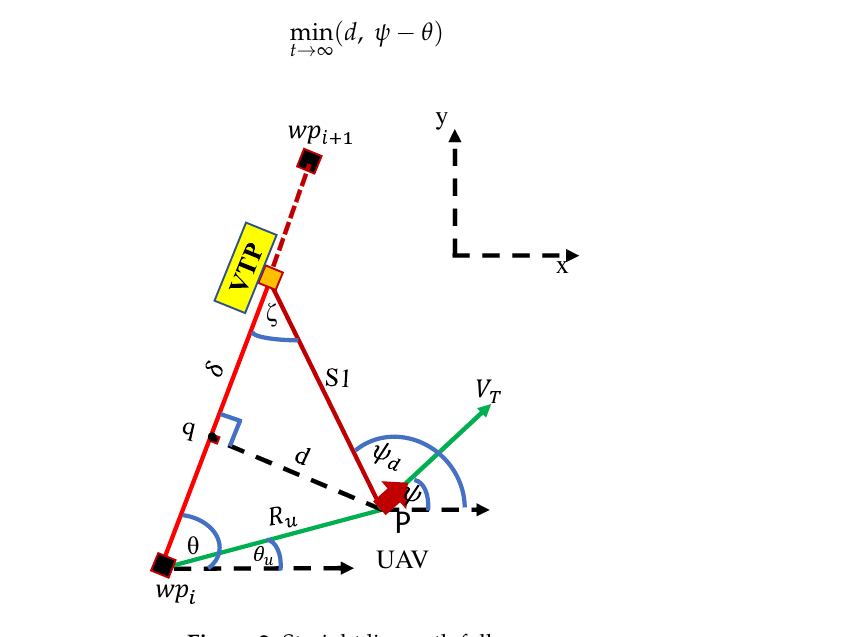
Figure 2. Straight line path